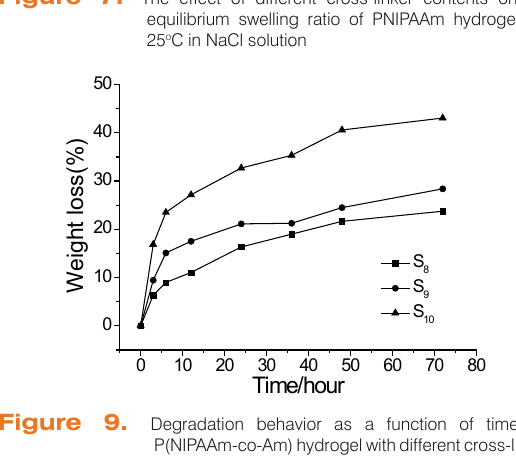
Figure 9. Degradation behavior as a function of time for P(NIPAAm-co-Am) hydrogel with different cross-linker content in SGF solution at 37°C.